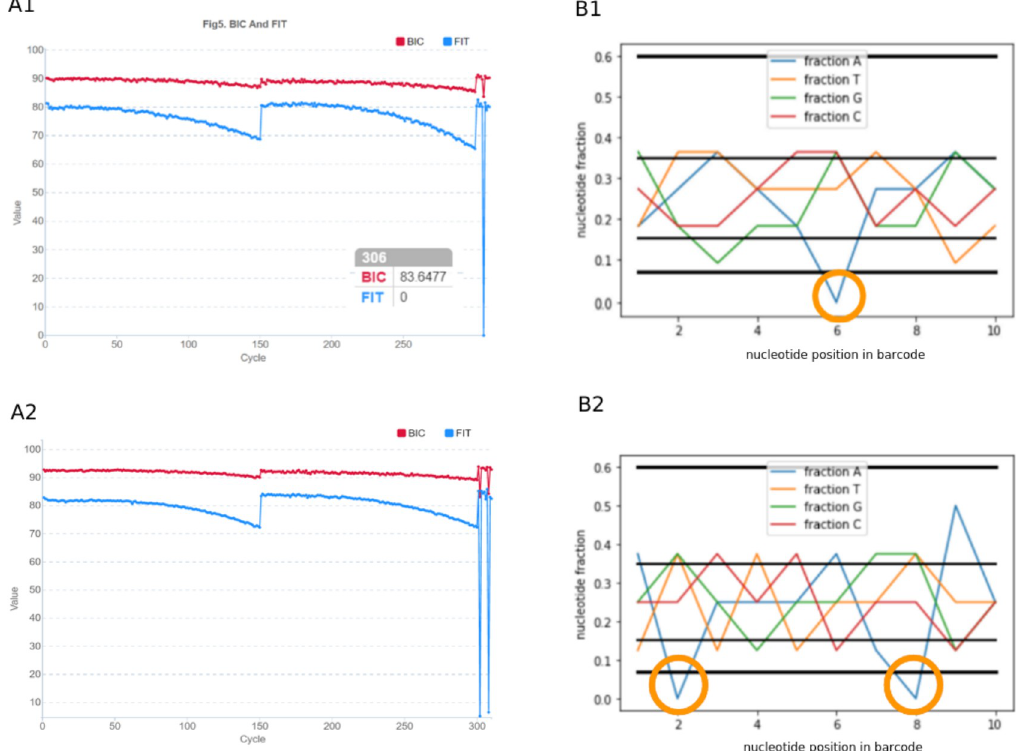
Fig 10. Examples of a direct relationship between FIT and lite criteria based on runs Z2 (A1, B1) Z3 (A2, B2): On the left, the graph from the MGI report, a drop in letters by FIT means that the nucleotide at this position was not recognized. On the right there is an example of how the script works, the drop outside the criteria is highlighted with circles. The FIT drop and the criterion drop are in the same positions in the bar code.